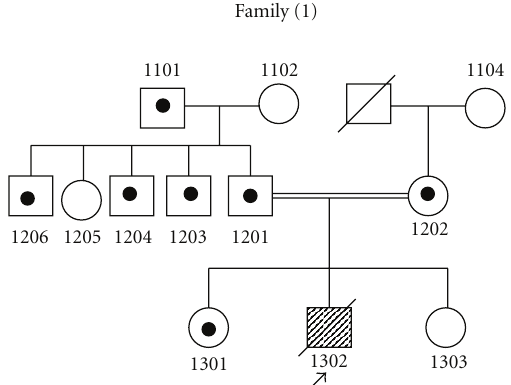
Figure 2: Pedigree of family (1) showing the genotyping of all individuals regarding c.253 254delGA mutation found in the proband (assigned by an arrow); pointed circles and squares are healthy carriers for the mutation while empty circles and squares are healthy individuals tested negative for this